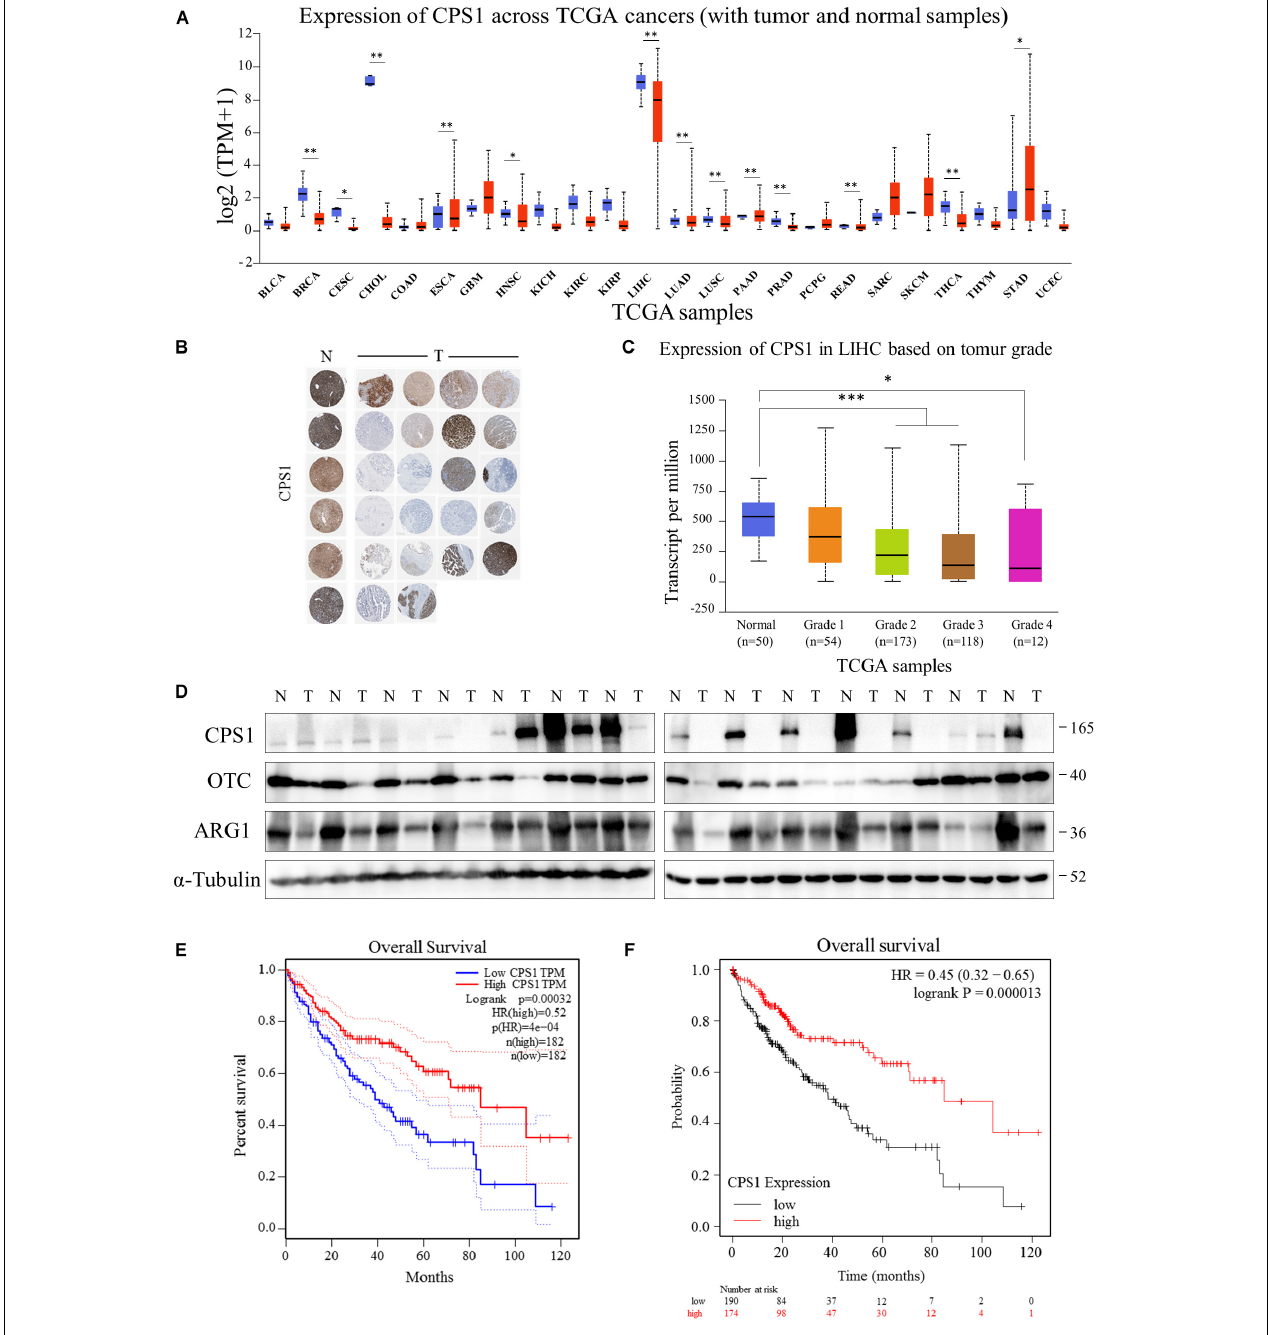
FIGURE 4 | The key enzymes of the urea cycle were often low expressed in HCC patients. (A) UALCAN portal analysis of cancer samples from the TCGA database (http://ualcan.path.uab.edu/). A comparison of CPS1 expression between normal and multiple cancer samples. Tumor tissues were shown in red, and normal tissues were shown in blue. BLCA, Bladder urothelial carcinoma; BRCA, Breast invasive carcinoma; CESC, Cervical squamous cell carcinoma; CHOL, Cholangiocarcinoma; COAD, Colon adenocarcinoma; ESCA, Esophageal carcinoma; GBM, Glioblastoma multiforme; HNSC, Head and Neck squamous cell carcinoma; KICH, Kidney Chromophobe; KIRC, Kidney renal clear cell carcinoma; KIRP, Kidney renal papillary cell carcinoma; LIHC, Liver hepatocellular carcinoma; LUAD, Lung adenocarcinoma; LUSC, Lung squamous cell carcinoma; PAAD, Pancreatic adenocarcinoma; PRAD, Prostate adenocarcinoma; PCPG, Pheochromocytoma and Paraganglioma; READ, Rectum adenocarcinoma; SARC, Sarcoma; SKCM, Skin Cutaneous Melanoma; THYM, Thymoma; STAD, Stomach adenocarcinoma; UCEC, Uterine Corpus Endometrial Carcinoma. (B) Expression of CPS1 of normal liver (N) and HCC (T) samples from The Human Protein Atlas (Human Protein Atlas available from http://www.proteinatlas.org). (C) UALCAN portal analysis of CPS1 expression between normal and different grade HCC samples from the TCGA database. (D) Western blot to detect the expression of CPS1, OTC, ARG1 and GAPDH from 14 pairs of cancer and adjacent tissues of HCC. (E,F) Survival probability between HCC patients with high and low CPS1 expression. The GEPIA database (http://gepia.cancer-pku.cn/) and Kaplan-Meier Plotter (http://kmplot.com/analysis/) were used to conduct survival analyses based on core gene expression. ∗ p < 0.05; ∗∗ p < 0.01, ∗∗∗ p < 0.001, ∗∗∗∗ p < 0.0001.